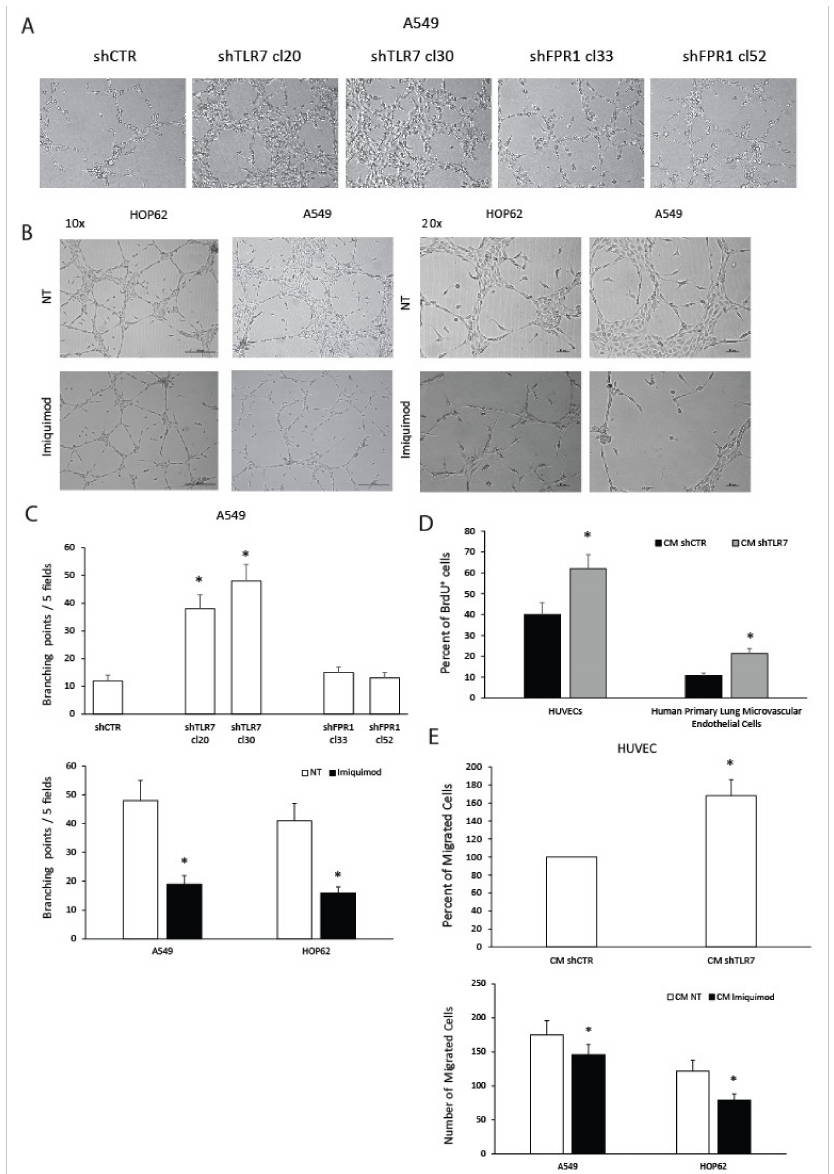
Figure 1. Effects of toll-like receptor 7 (TLR7) modulation in non-small cell lung cancer (NSCLC) cells on functional angiogenic responses. Human umbilical vein endothelial cells (HUVECs) were cultured in the presence of cell culture conditioned media (CM) from A549 shCTR (a mass population), shTLR7 (two clones), and shFPR1 (two clones) ( A ), or CM from A549 or HOP62 treated or untreated (NT) with imiquimod (1 µ g/mL) (10 × and 20 × magnifications) ( B ) in a 24-well plate. After 3 days, cells were fixed with ice-cold 70% ethanol, and tubule formation was evaluated. Sample images ( A , B ) and a quantification of the angiogenic response ( C ) are reported. Data are represented as mean ± SD of three independent experiments. * p < 0.05 compared to the control. ( D ) Cell proliferation assessed as BrdU incorporation of endothelial cells (HUVEC and human primary lung microvascular endothelial cell (HPLMEC)) cultured for 36 h in CM of A549 shCTR (a mass population) and shTLR7 (2 clones). Data are represented as mean ± SD of three independent experiments. * p < 0.05 compared to the control. ( E ) Percent of HUVEC migrated cells toward CM from A549 shCTR (a mass population) and shTLR7 (two clones) or from A549 and HOP62 cells treated or not with imiquimod (1 µ g/mL). Data are represented as mean ± SD of three independent experiments. * p < 0.05 compared to the